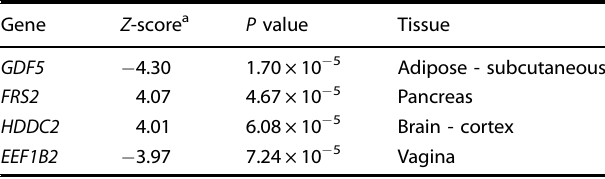
a Represents the number of standard deviations the mean expression of the gene in ACT cases is from that of controls, after adjusting for the weight of each eQTL in fl uencing expression of the